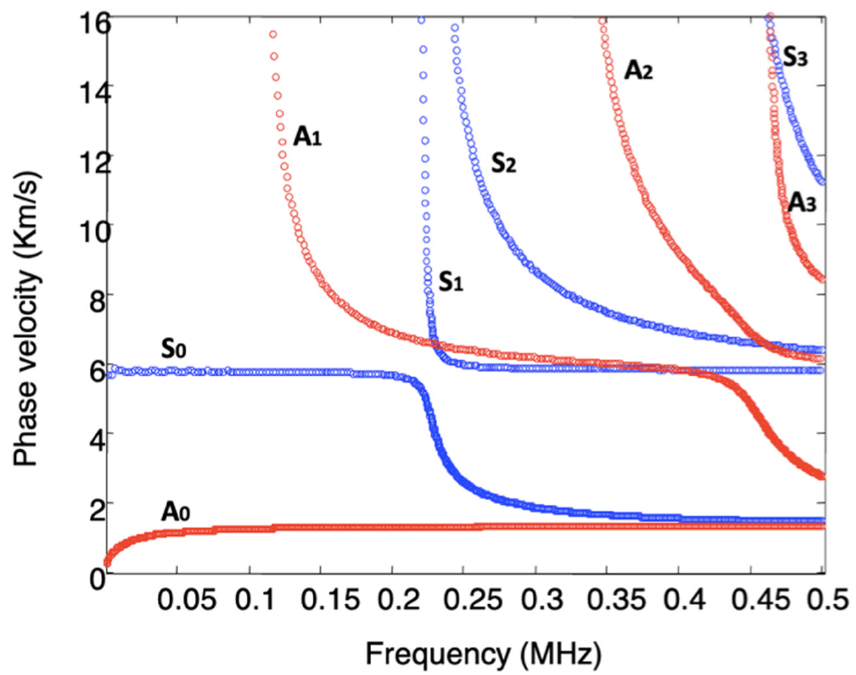
Figure 2. Optimized phase velocity dispersion curves corresponding to 6.2 mm-thick composite plate.